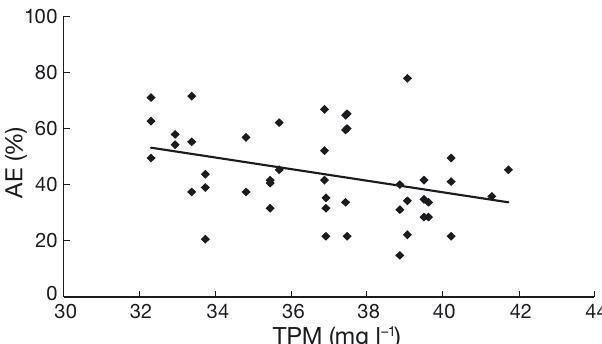
Fig. 3. Relationship between absorption efficiency (AE) of sil- ver carp Hypophthalmichthys molitrix and total particulate matter (TPM)